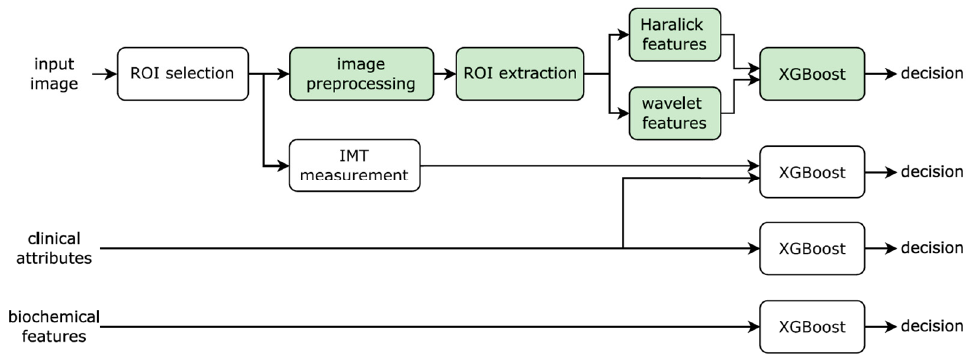
Figure 2. Block diagram of the proposed methodology. The new parts that our method consists of are framed in green, while the steps done previously or done only for the experimental comparison have a think frame. ROI, region of interest; IMT, intima-media thickness.